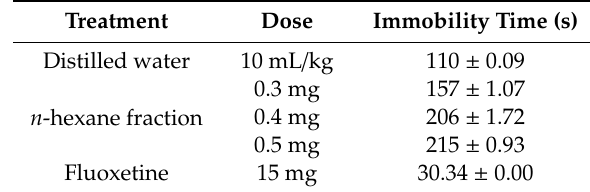
Table 5. Antidepressant activity of n -hexane fraction of V. betonicifolia whole-plant. Treatment